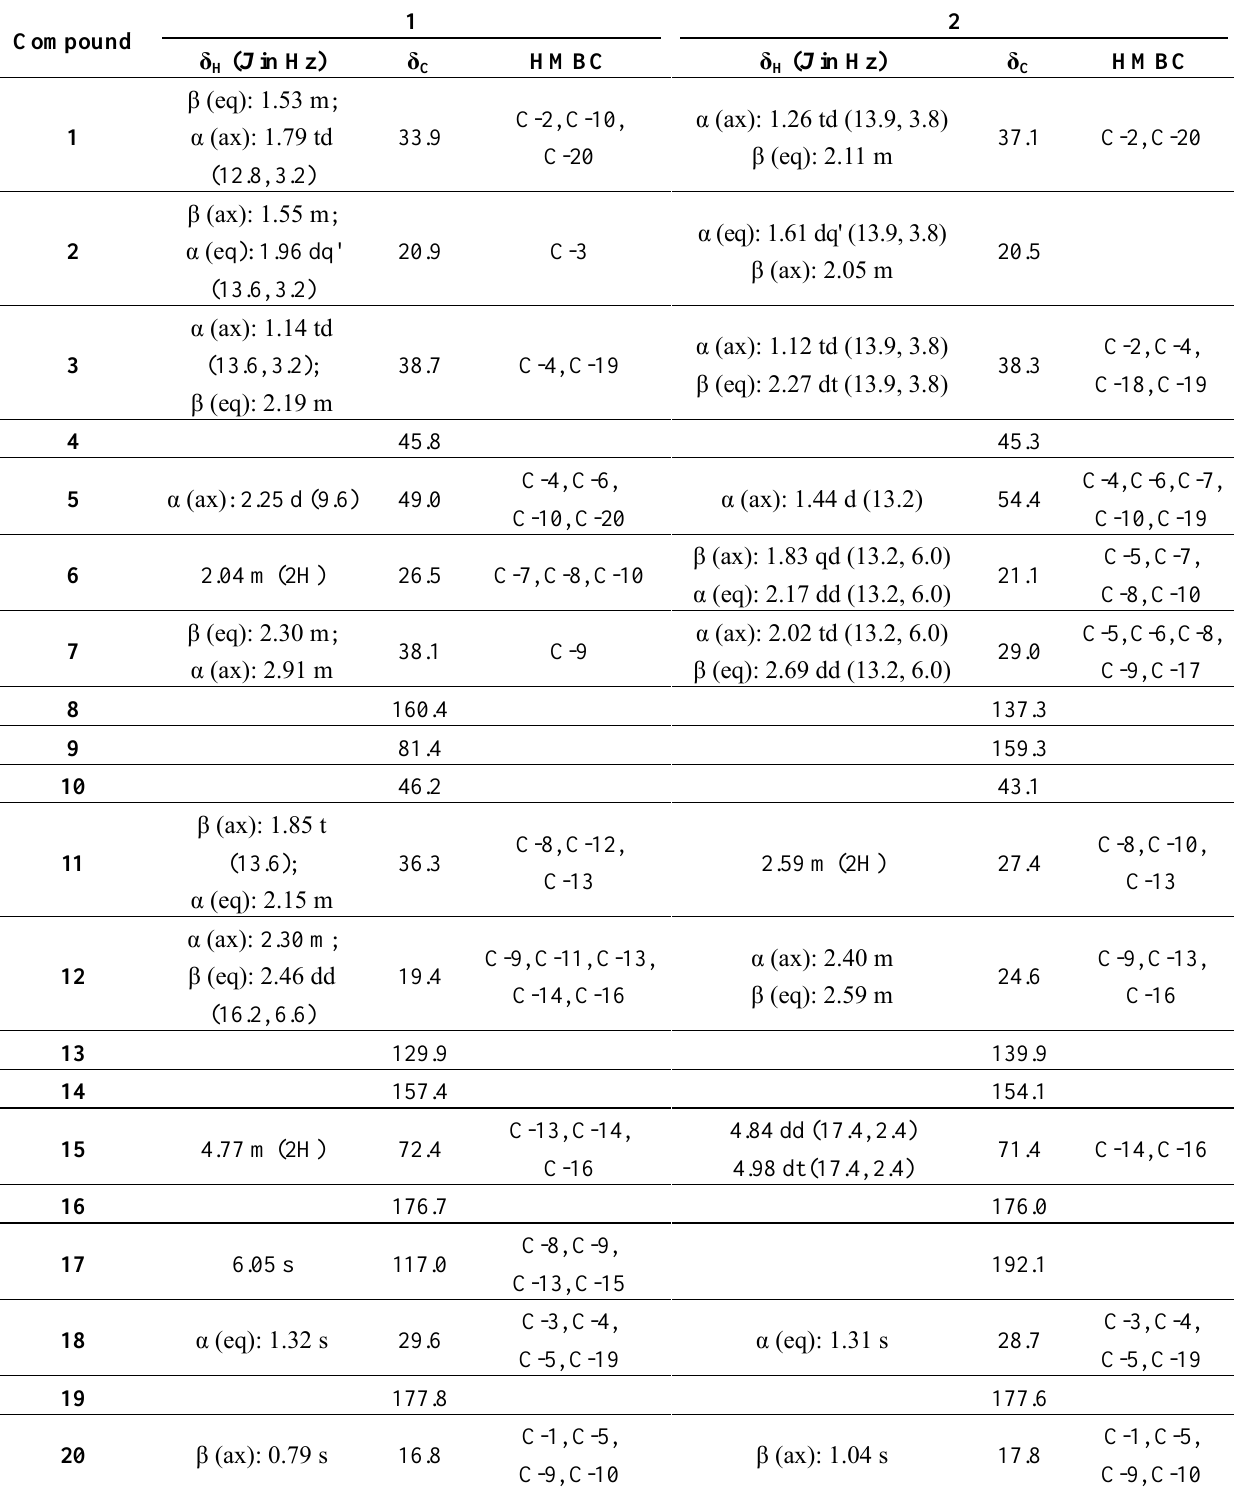
Table 1. 1 H and 13 C NMR spectral data and heteronuclear multiple bond correlation (HMBC) correlations for compounds 1 and 2 in